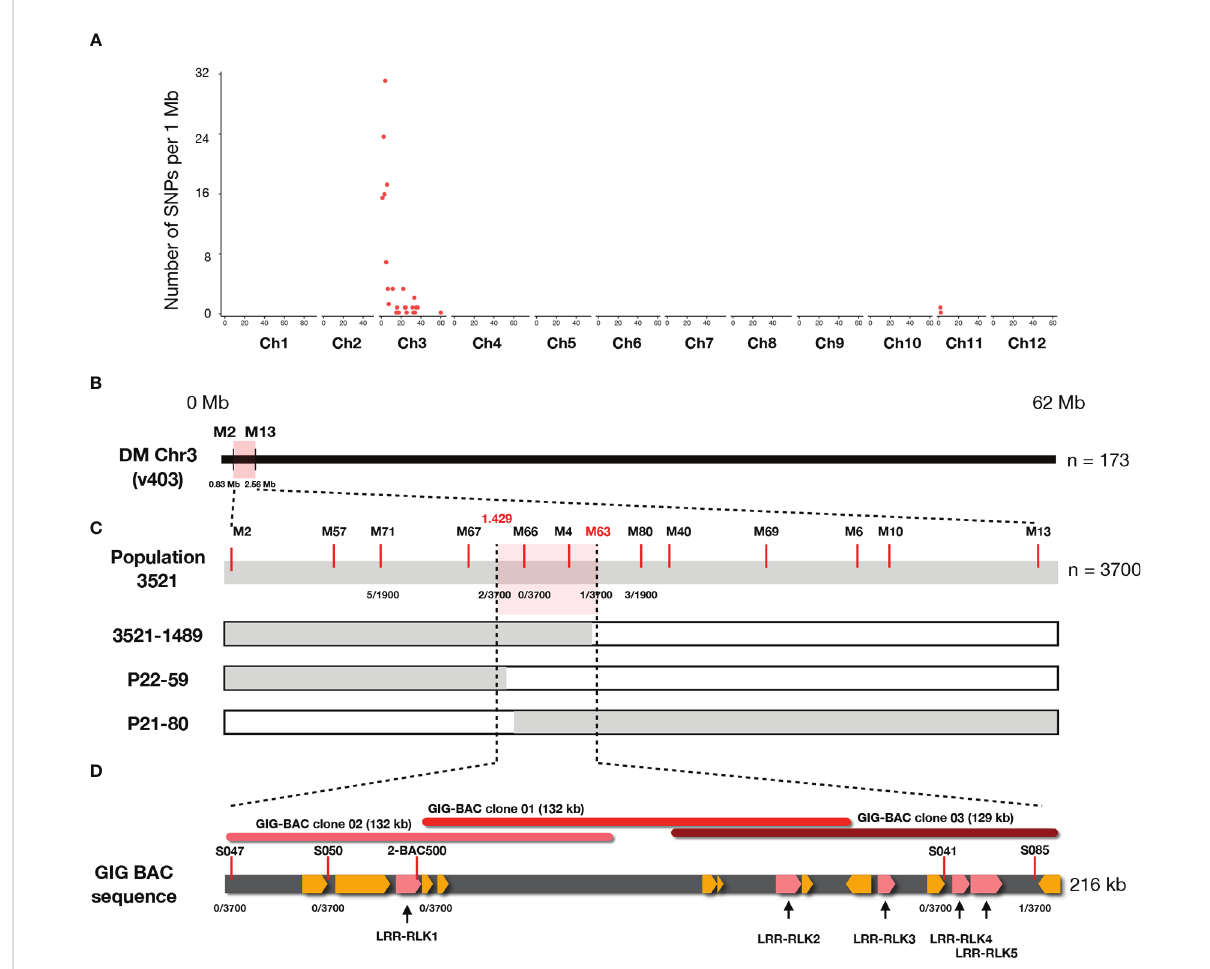
FIGURE 3 The Pep-25 receptor is fi ne-mapped to an RLK gene locus in Solanum microdontum . (A) The number of fi ltered SNPs per 1 Mb interval are visualized ( y axis), the chromosome IDs are shown in x axis. Most of the informative SNPs are located on the top of chromosome 3, based on the potato reference genome (DM v4.03). (B) The Pep-25 receptor is mapped to a 1.73 Mb interval, between markers M2 and M13. (C) Fine- mapping of Pep-25 receptor in population 3521 (n=3700) to a 0.081 cM interval, between markers 1.429 and S085. Markers are shown with red lines, markers M66 and M4 are co-segregating with the Pep-25 response, the number of recombination/total plants are shown below the markers. (D) . A 216 kb contig generated from three BAC clones (01-03) from GIG362-6 shows 15 predicted RLK genes (highlighted yellow), fi ve of these RLK are up-regulated upon P. infestans infection (highlighted by